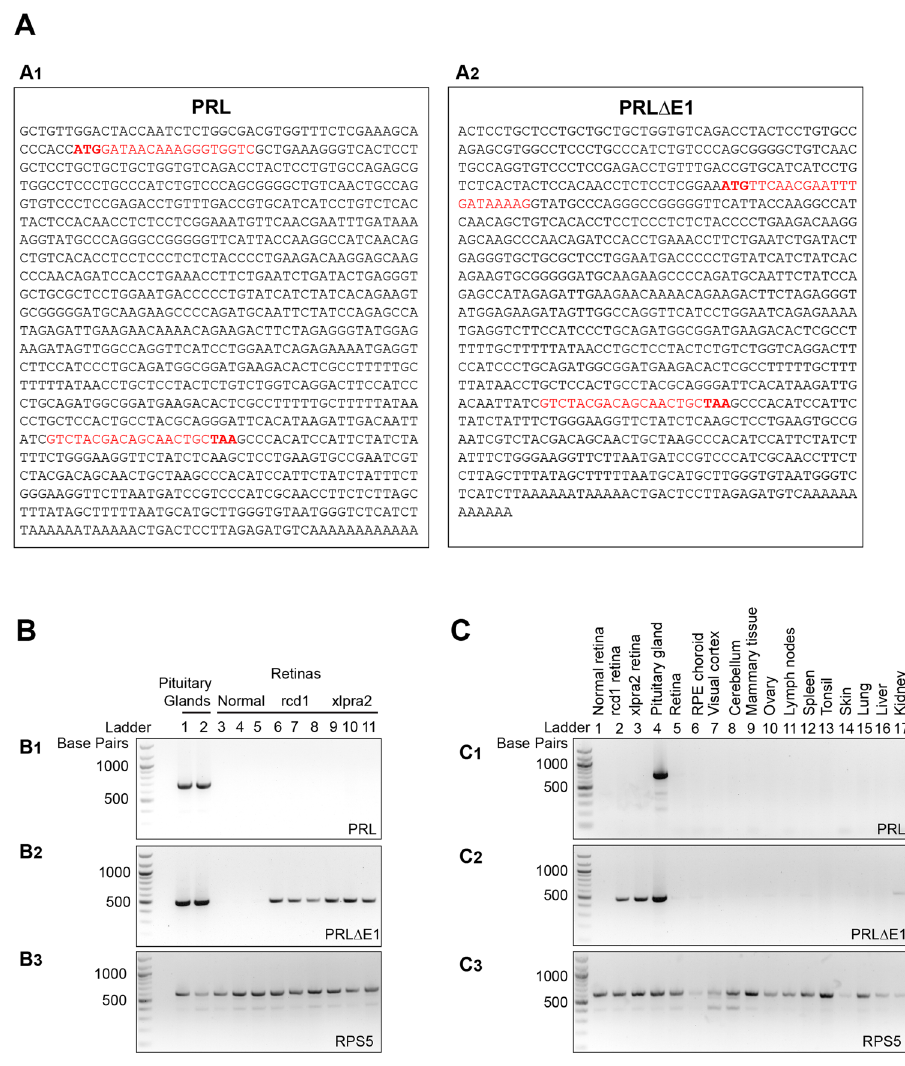
Figure 2. Expression of full length and short PRL transcripts in canine tissues. (A) Nucleotide sequences of full length (A1) and short (A2) canine PRL isoforms with positions of the translational start (ATG) and end (TAA) sites, and forward and reverse primers (red) used for PCR amplification. ( B) PCR amplification of PRL transcripts from pituitary gland and retinas (normal and mutant). The full length PRL transcript is found in pituitary gland (n = 2 dogs) but not in retina (n = 3 dogs per group) (B1) , whereas the short PRL isoform is found only in mutant retinas (B2) . Amplification of housekeeping gene RPS5 was included as a control (B3) . ( C) Analysis of PRL mRNA expression in various tissues from a normal dog. Full length PRL is expressed only in the pituitary gland (C1) , whereas the PRLΔE1 isoform is found in mutant retinas but also in pituitary gland and in kidney of the normal dog (C2) . Amplification of RPS5 was included as a control (C3)